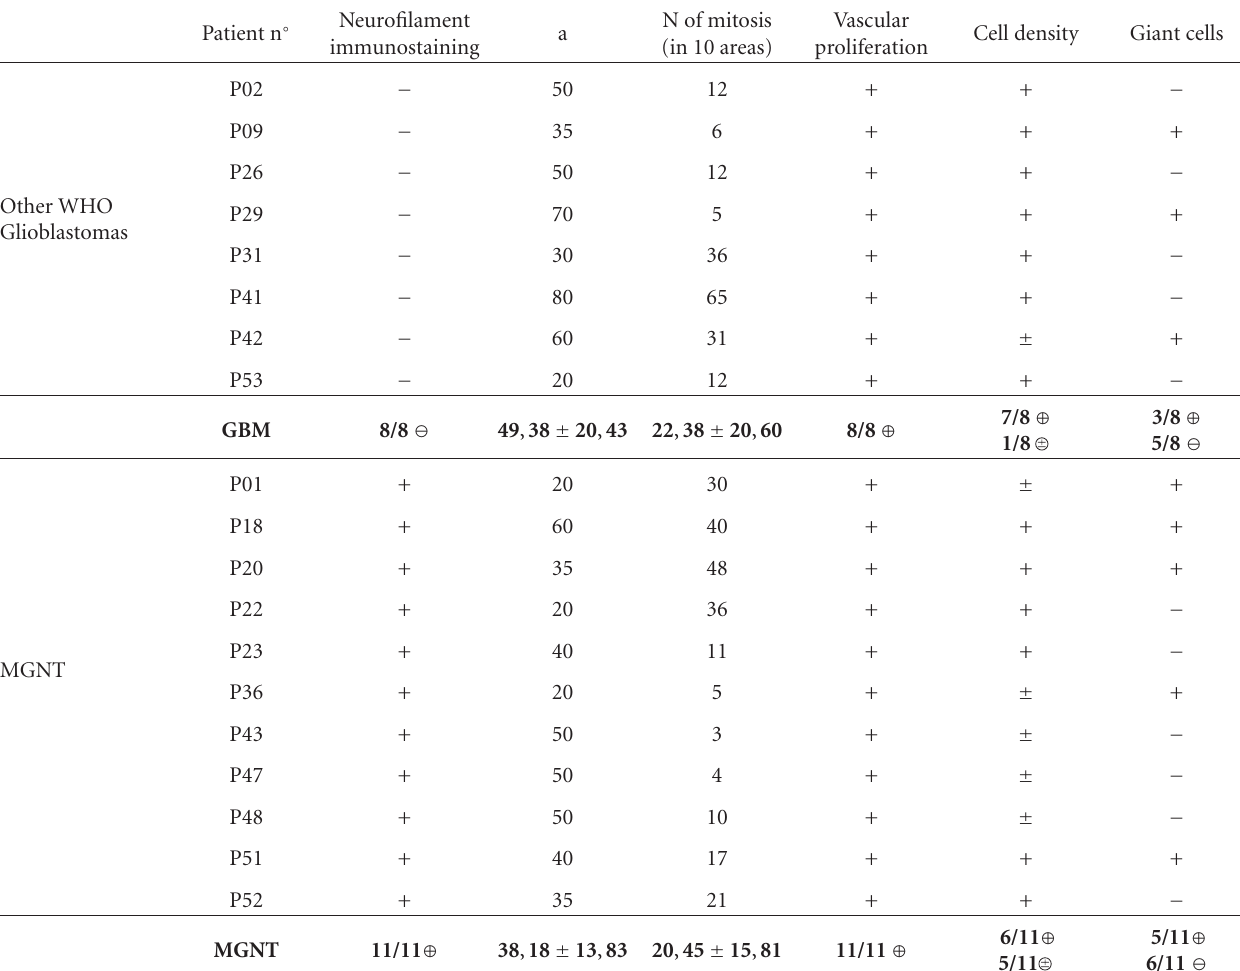
Table 1: MRI and pathology data